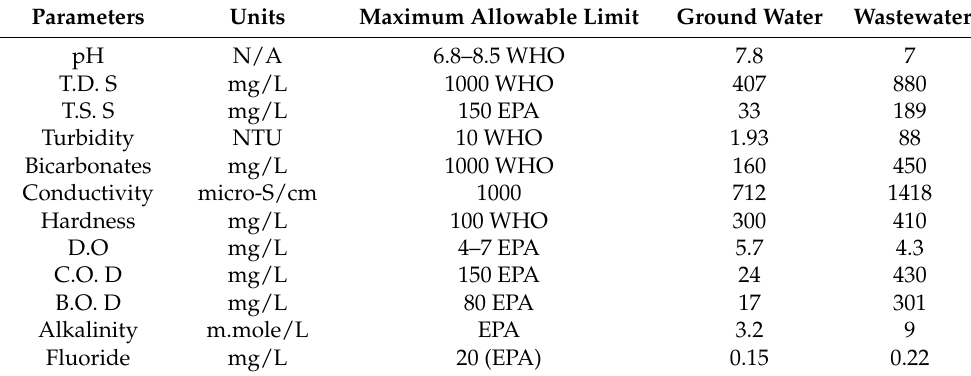
Table 2. Chemical analysis results of water samples.